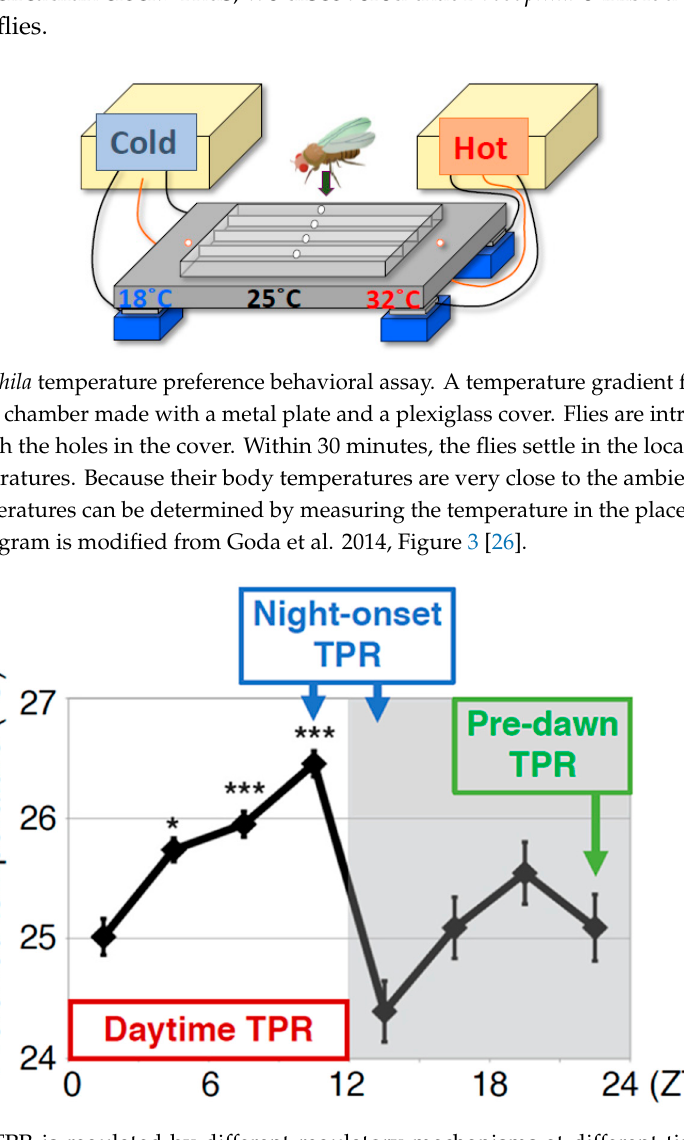
Figure 3. The TPR is regulated by different regulatory mechanisms at different times of the day: daytime, night onset, and predawn. Daytime TPR: The increase in preferred temperature during the daytime (ZT 1–12: shown by the red rectangle). Night-onset TPR: The dramatic decrease in preferred temperature at the transition from day to night (ZT 10–15: shown by blue rectangle). Predawn TPR: The preferred temperature just before dawn is similar to that of early morning (ZT 22–24: shown by green rectangle). The TPR is regulated by different regulatory mechanisms in each of these periods. The graph is modified from Kaneko et al. 2012, Figure 1 [18]. *: p < 0.05, ***: p < 0.001 (comparison to ZT